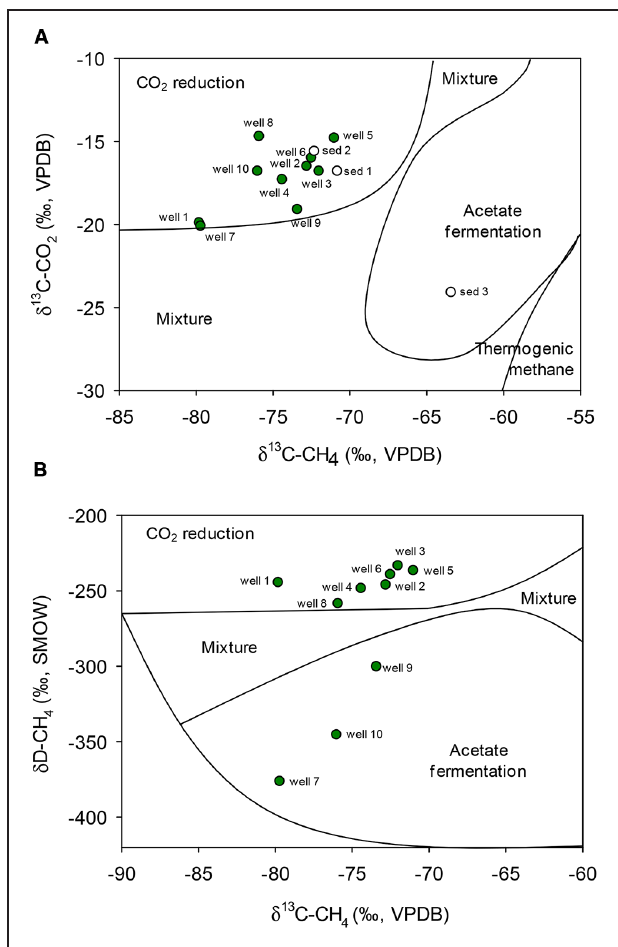
FIGURE 1 | Genetic diagrams for gasses of different samples: carbon isotopic composition of natural methane and CO 2 in groundwater samples from deep aquifers of coal-rich sedimentary basin and sediments (A). Hydrogen vs. carbon isotopic composition of methane ( δ 13 C CH4 and δ D CH4 ) of natural methane in groundwater samples (B) . Zoning after Schoell (1980, 1983) and Whiticar et al. (1986). VPDB, Vienna PeeDee Belemnite; SMOW, Standard Mean Ocean